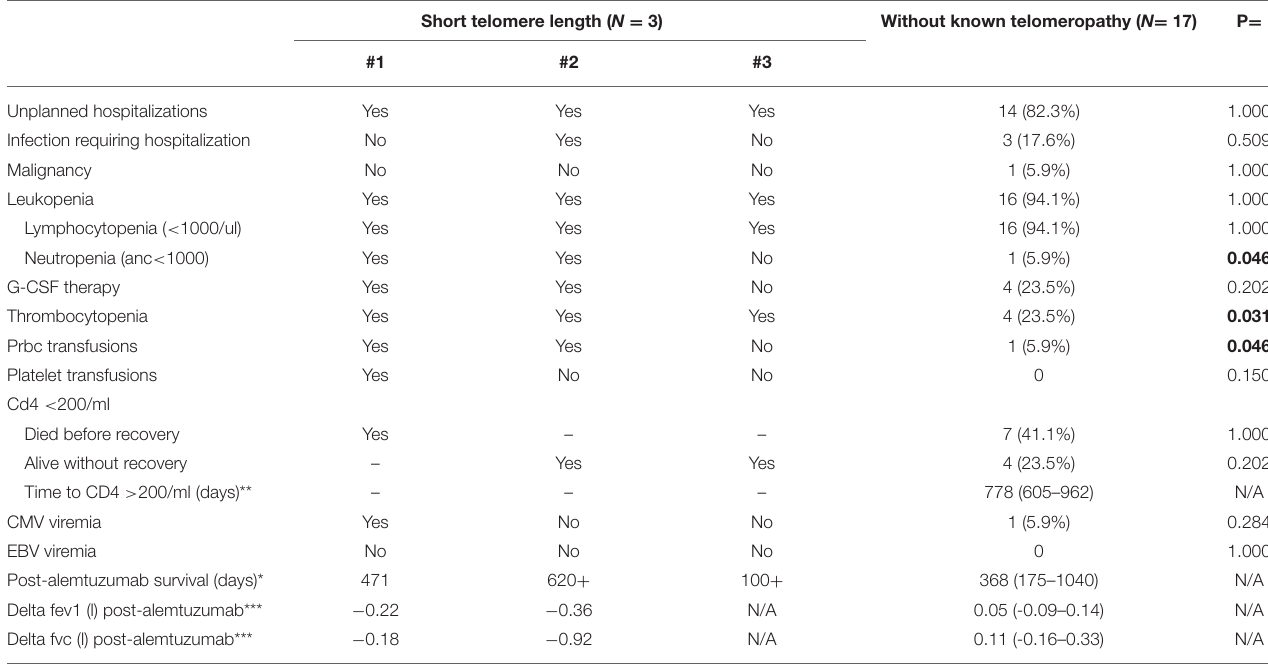
TABLE 3 | Outcomes in patients receiving